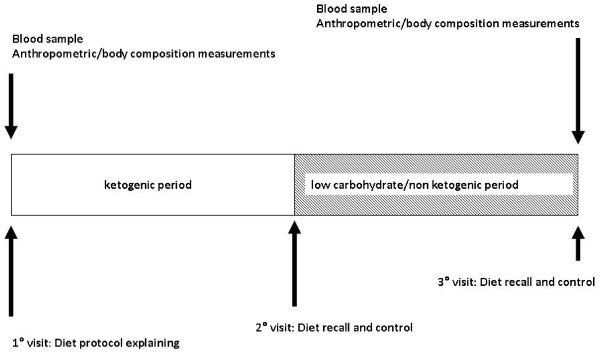
Experimental design.